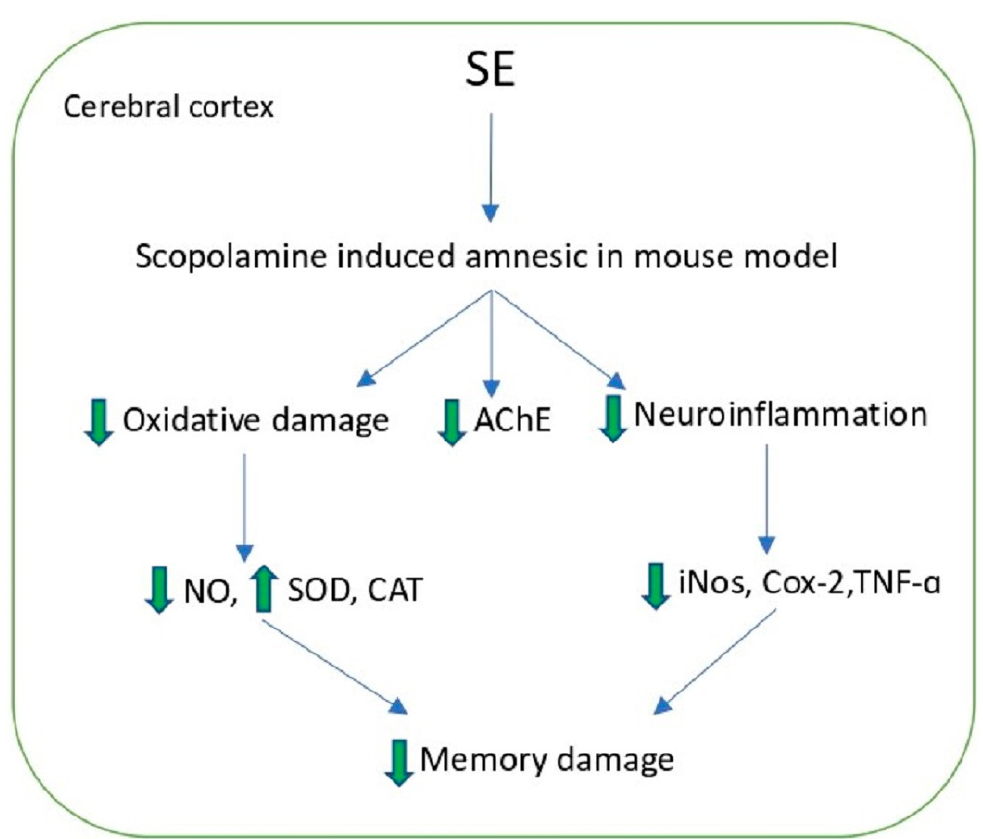
Figure 5. Ameliorative effect of Salicornia extract (SE) on Scopolamine induced